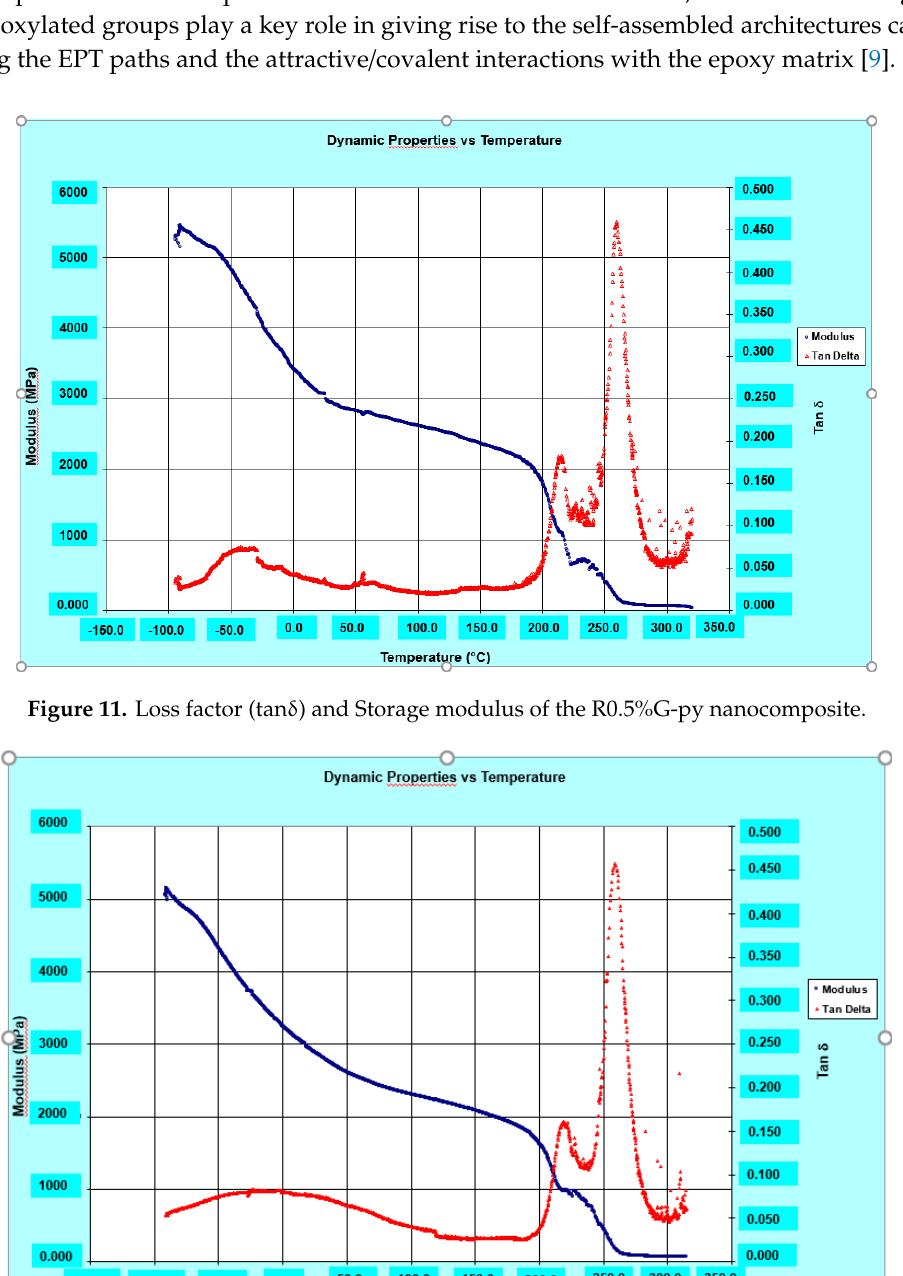
Figure 13. Loss factor (tan δ ) and Storage modulus of the unfilled epoxy matrix R. 3.5. Differential Scanning Calorimetry (DSC) Investigation and Thermogravimetric Analysis (TGA) of G and G-py Nanofillers and their Corresponding Nanocomposites In order to better understand and interpret the thermogravimetric data for the different analyzed systems, the TGA trend (with the thermodegradation temperatures T d and residue values) in air of the unfunctionalized G and non-covalently functionalized G-py nanofillers is shown in Figure 14. From the TGA curves, it can be clearly seen that for the functionalized sample G-py (see the black curve) the beginning of the thermodegradation phenomenon moves to a higher temperature of about 70 °C compared to unfunctionalized G (see the blue curve). More precisely, the non-covalent functionalization of graphene with pyrene derivative significantly improves the thermal stability of the starting unfunctionalized nanocharge G, effectively increasing the oxidative thermostability of the composite because the evolution of CO 2 shifts to higher values. The thermodegradation temperatures T d are 310 °C for G sample and 670 °C for G-py sample, while instead, a residue of 9%